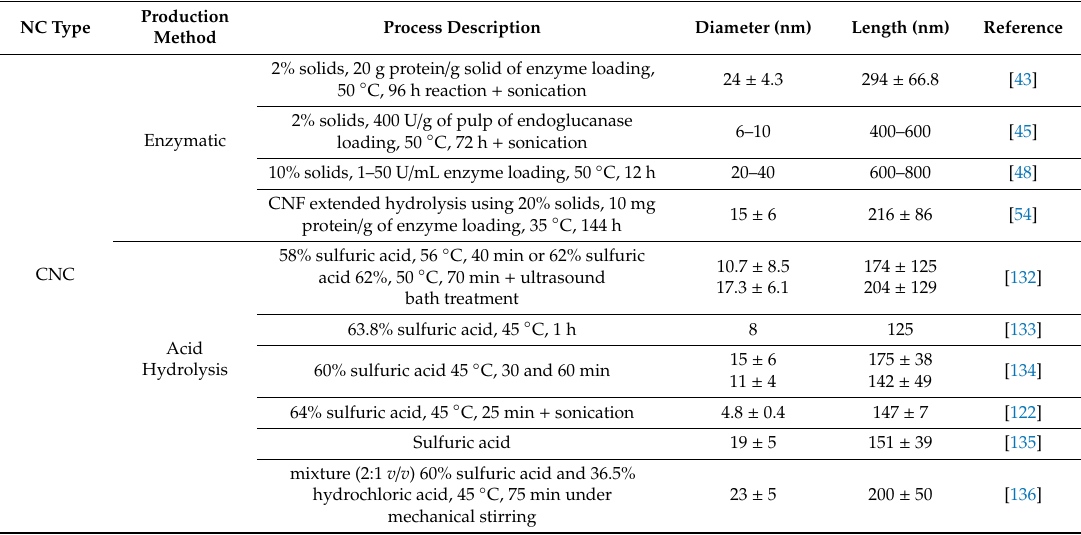
Table 3. Size of NC obtained from bleached eucalyptus Kraft pulp (BEKP) from enzymatic treatment and other production